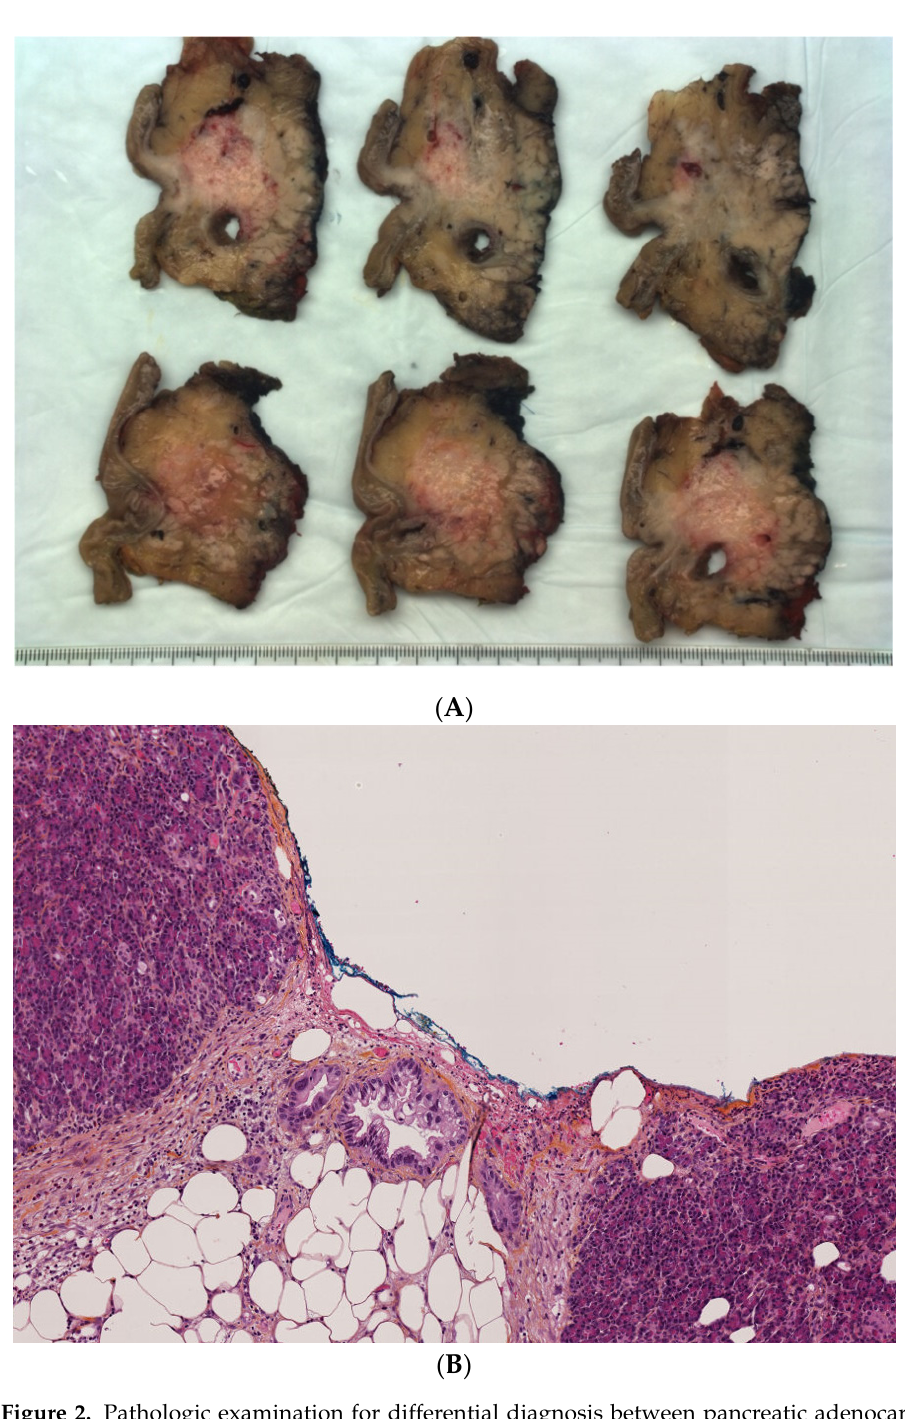
Figure 2. Pathologic examination for differential diagnosis between pancreatic adenocarcinoma and distal cholangiocarcinoma after pancreaticoduodenectomy. ( A ) Serial slicing, macroscopic view. Black arrow indicate the tumor; dot line arrow indicate the biliary tract; circle indicate the ampullary. ( B ) Hematoxylin and eosin staining of the same patient sample, microscopic view. Black arrow indicate the positive margin (in blue ink). The distance with adenocarcinoma gland is within 1 mm. Dot line arrow indicate the adenocarcinoma glandular cell.